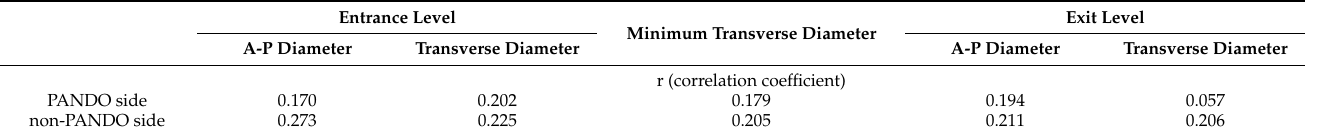
Table 3. Correlation between age and the bony nasolacrimal duct.